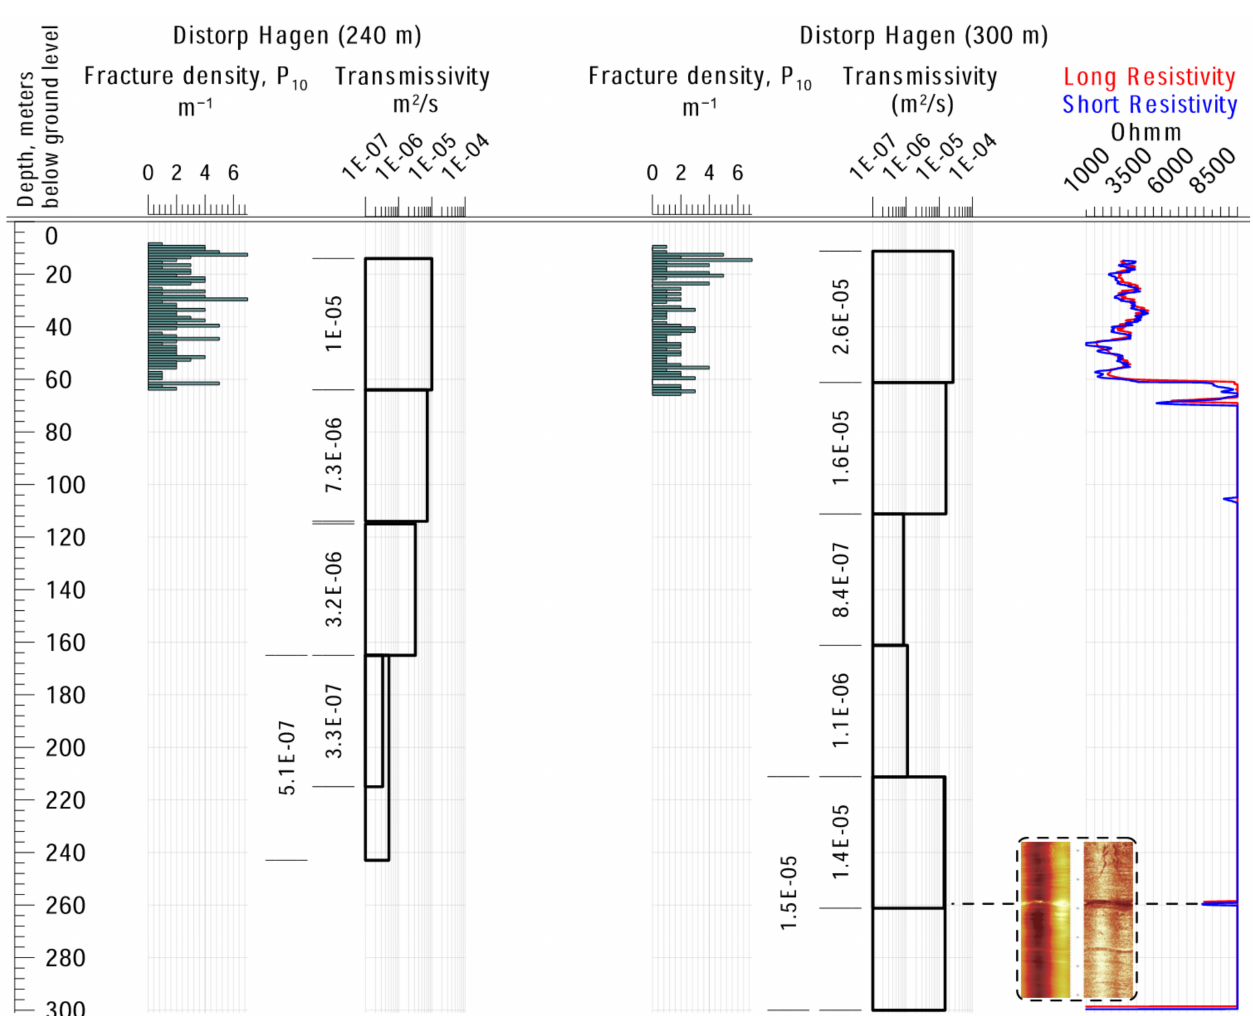
Figure 10. Transmissivity estimates with measured depth below ground level for the 240 m and 300 m deep Distorp Hagen